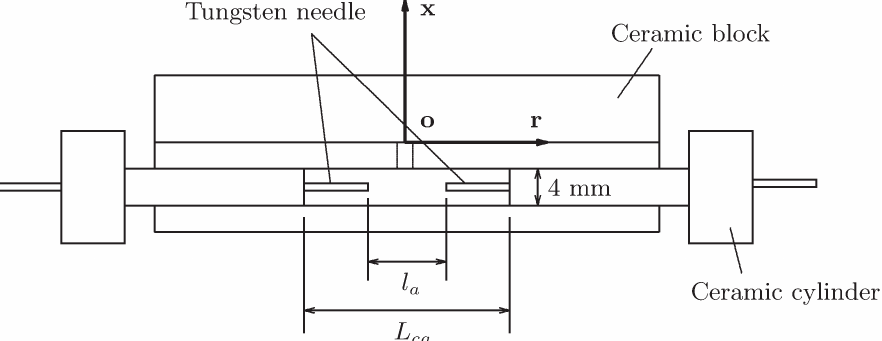
Figure 25. Small cavity